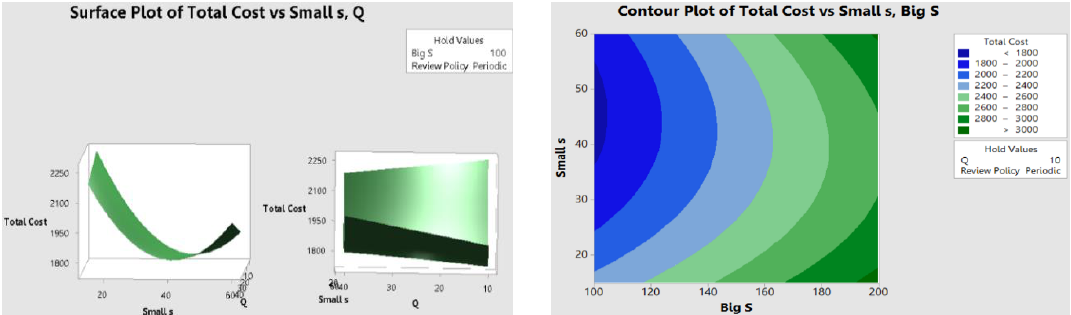
Figure 17. Surface and contour plot of Box-Behnken design.